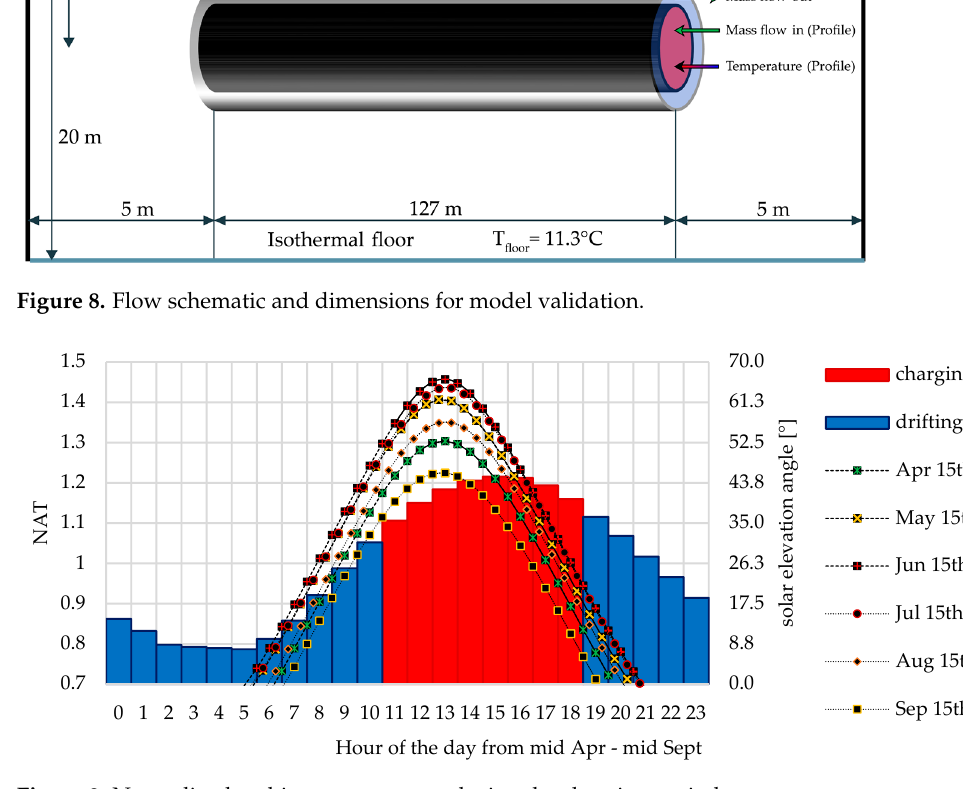
Figure 9. Normalized ambient temperature during the charging period. The simplification of straightening the heated borehole (BOHR2) required an adjust- ment of the sensor positions. Vectors for linear segments defined by global positioning system (GPS) waypoints on BOHR2–BOHR6 and vectors for temperature sensors along Figure 10. Vector analysis of temperature sensor location to heated borehole. each segment were used to determine sensor locations relative to the heated borehole in 3 Figure 10. Vector analysis of temperature sensor location to heated dimensions. Measurement data in borehole Figure 10 below show how this process works in 2 dimensions.